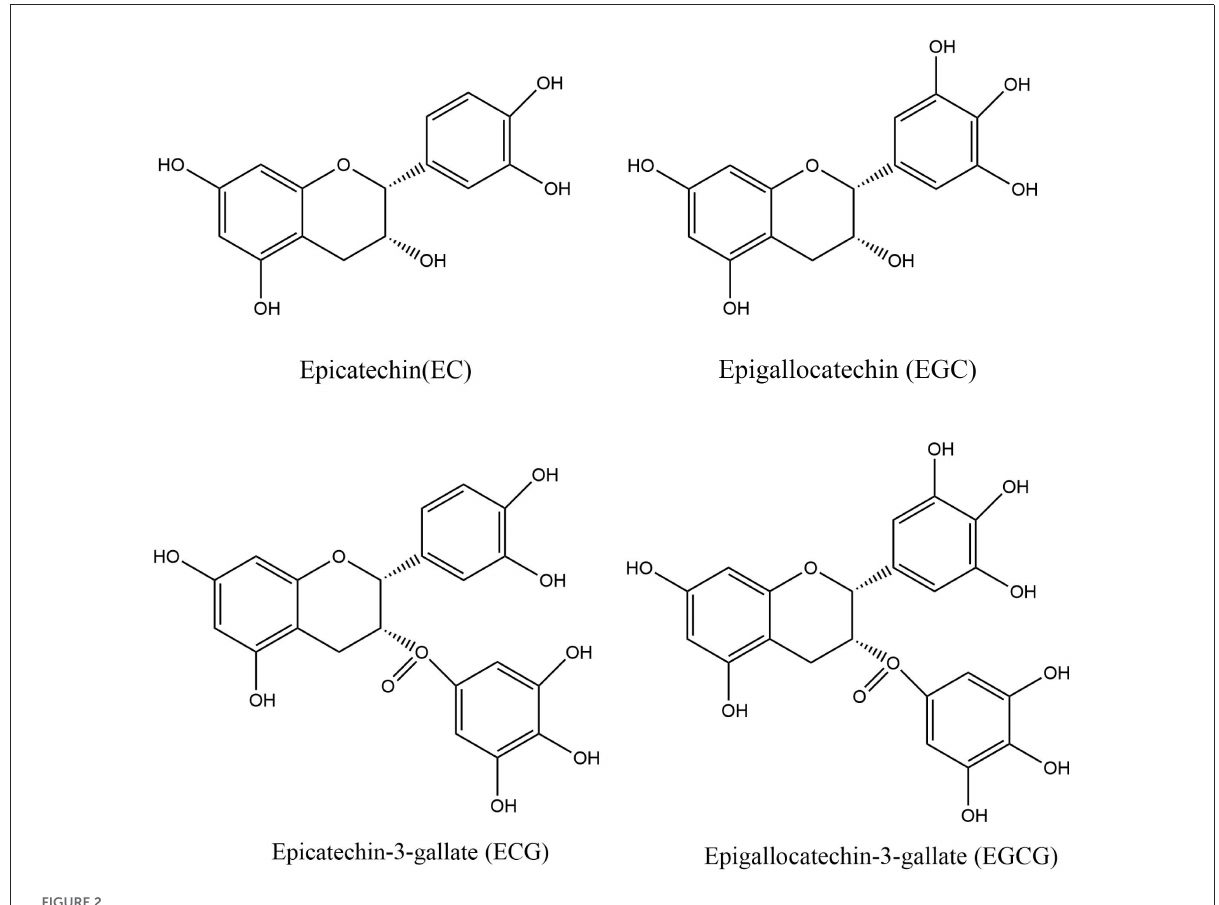
FIGURE2 Structure of EC, ECG, EGC, and EGCG.